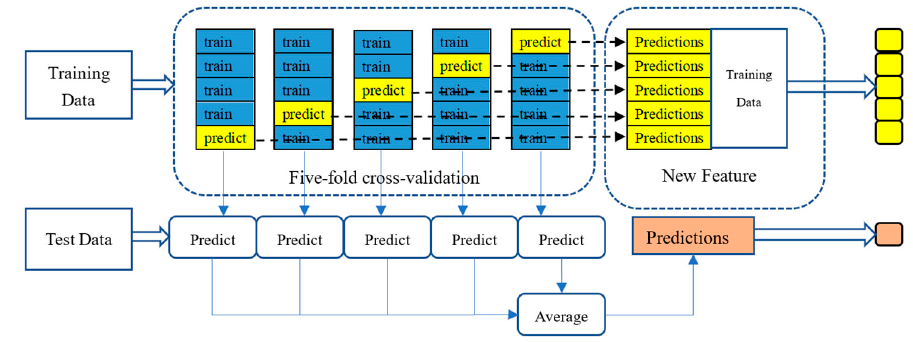
Figure 4. Structure of the five-fold cross-validation process.